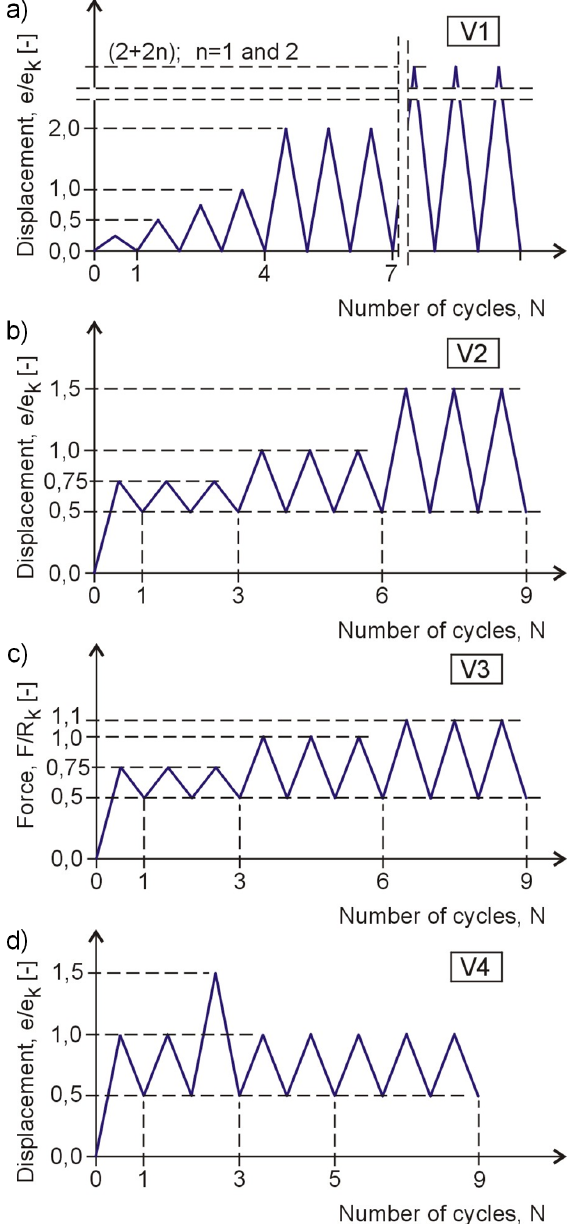
Figure 3: Variable loading histories; a) cyclic according to ECCS; b) repeated with displacement control, c) repeated with force control, d) repeated with overload in third